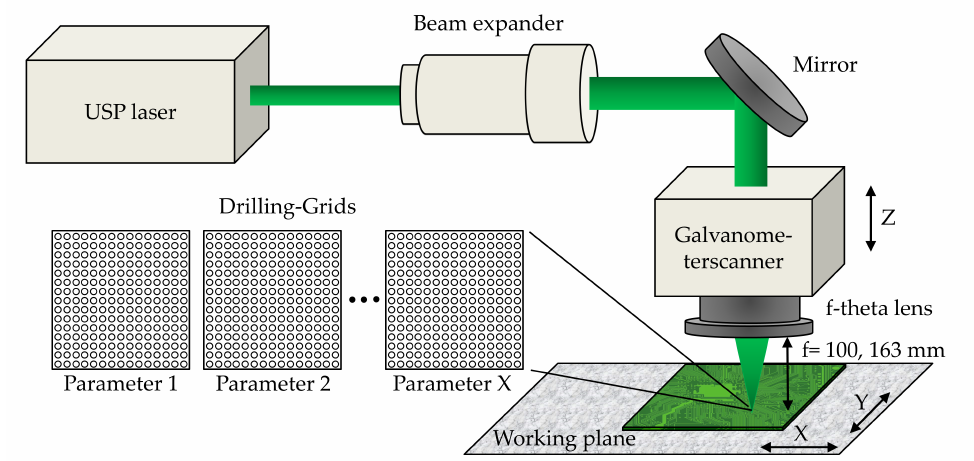
Figure 2. Setup for investigations of pulse to pulse interactions in the percussion drilling of microvias in FR-4 PCB material. Table 1. Technical specification of the ultrashort pulse laser systems and experimental data of the used laser beam configurations for experimental investigations of microvia